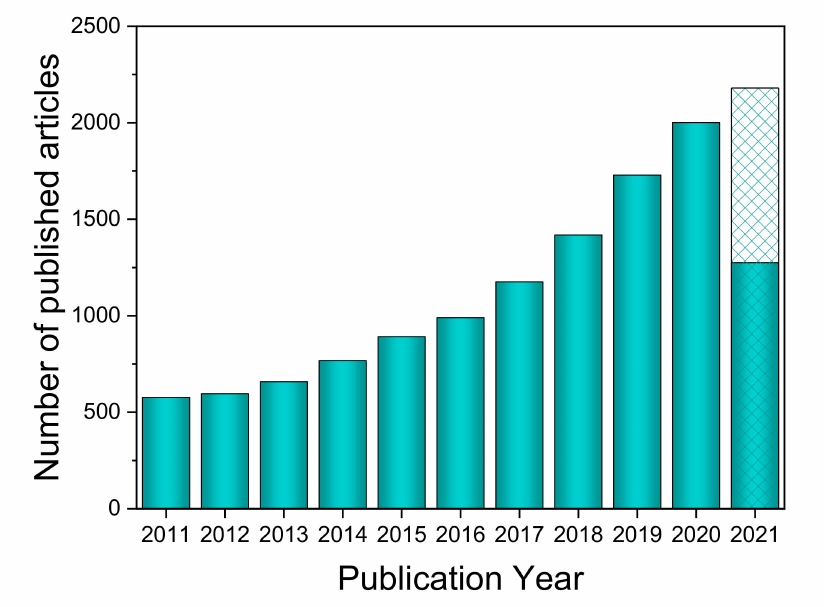
Figure 1. Trend of published articles on the topic of water electrolysis in the last 10 years (source Scopus 8 July